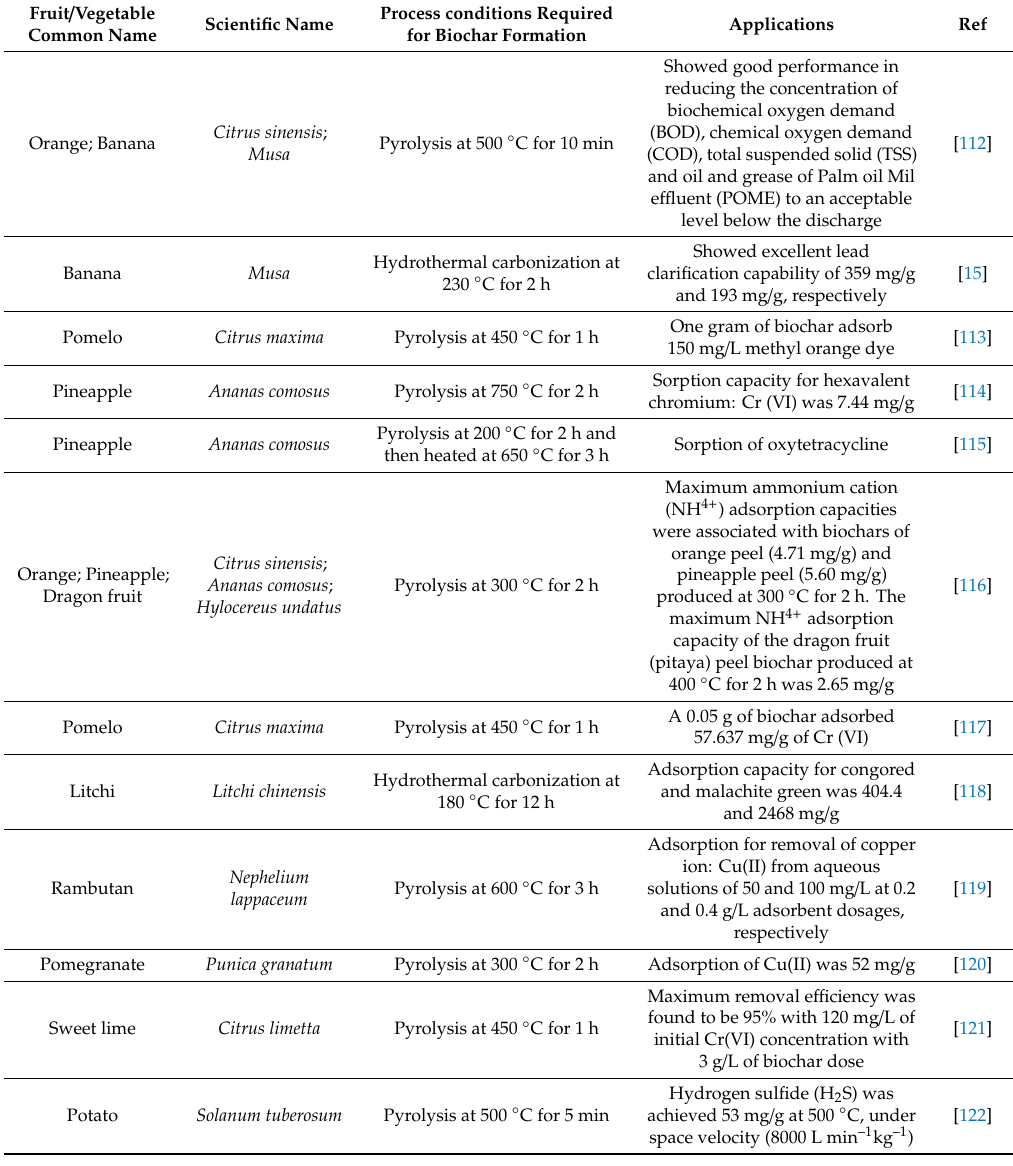
Table 5. Fruits and vegetables peel derived biochar and its